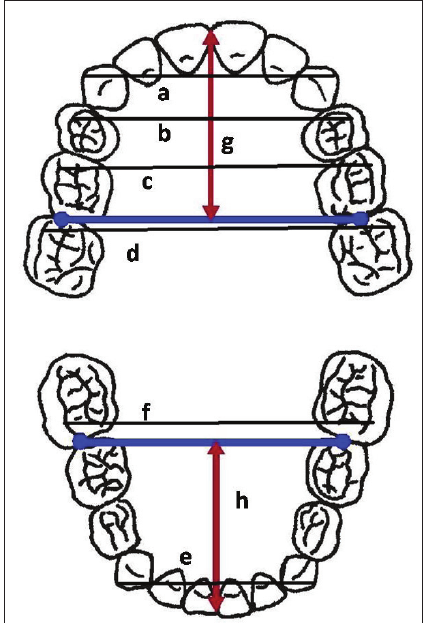
Figure 5. Dental cast measurements: (a) maxillary Figure 6. Frontal cephalometric measurements. HRP: Horizontal reference plane (between right intercanine width, (b-c) maxillary inter-premolar and left latero-orbitale points). VRP: Vertical reference plane (perpendicular to HRP). (a) widths, (d) maxillary inter-molar width, (e) mandibular inter-canine width, (f) mandibular inter-molar width, (g) maxillary arch depth, (h) mandibular arch depth.